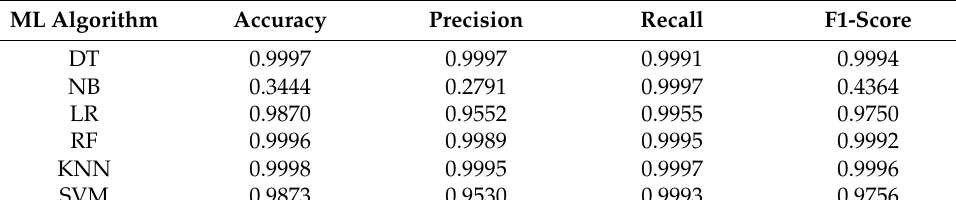
Table 10. Evaluation metrics for binary classification for the “Train_Test edge network” dataset.